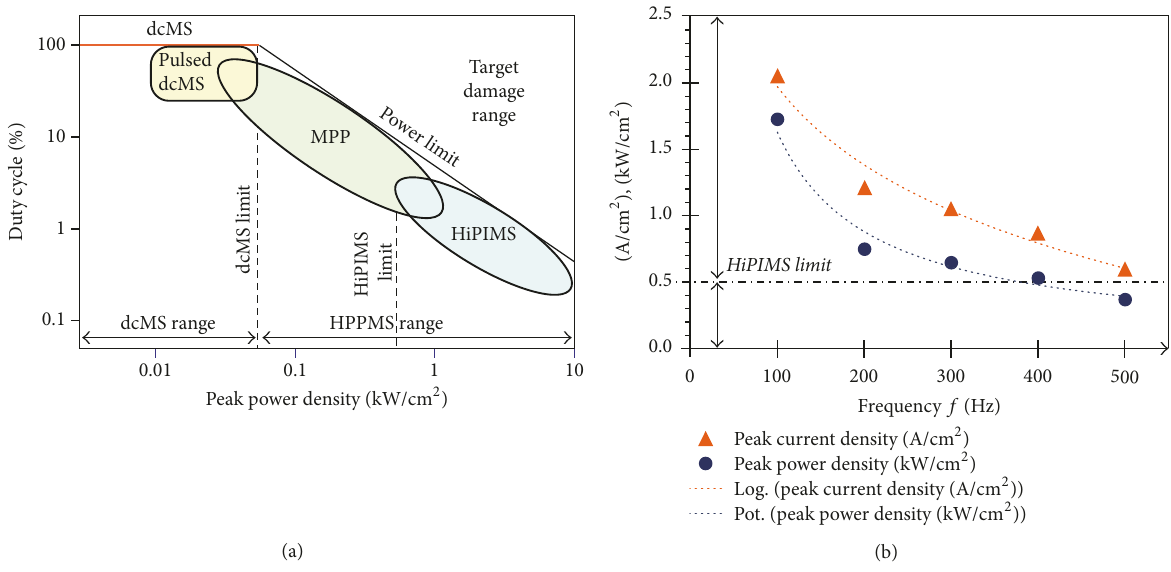
Figure 1: (a) Nomenclature for dc pulsed discharges based on the peak power density 𝑝 𝑡 at the target, combined with the duty cycle (adapted fromGudmundssonetal.[17]).(b)Peakcurrentdensityandpeakpowerdensityfordifferentfrequenciesintherangeof100–500 Hzmeasured during HPPMS discharge at a constant pulse length of 50 𝜇 s and mean power of 4kW at 0.6 Pa. Table 1: Process parameters for heating, cleaning, and deposition of the (Al,Ti)N coatings in the present study. Process Time Parameter Value and unit